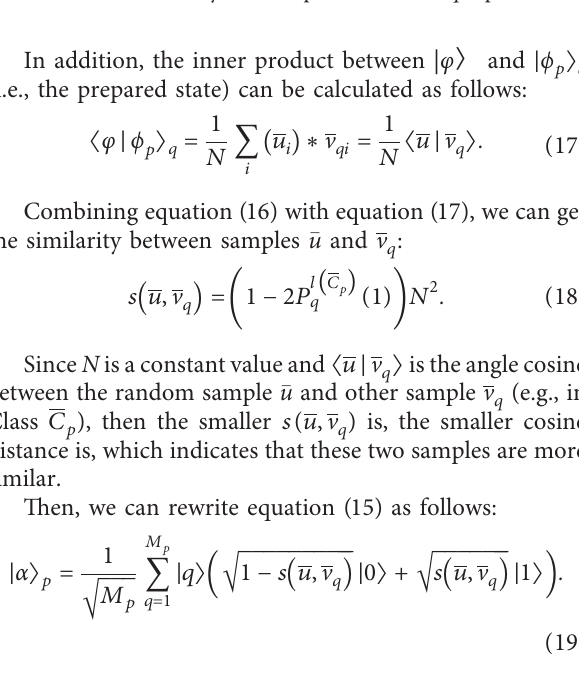
Figure 3: Quantum circuit of swap test operation; the symbol of two crosses connected by a line represents the swap